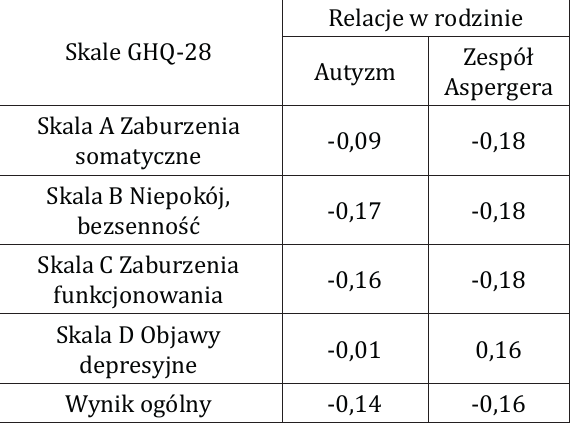
Tabela 8. Współczynniki korelacji obliczone między oceną relacji w rodzinie a wynikami Kwestionariusza GHQ-28 w grupie